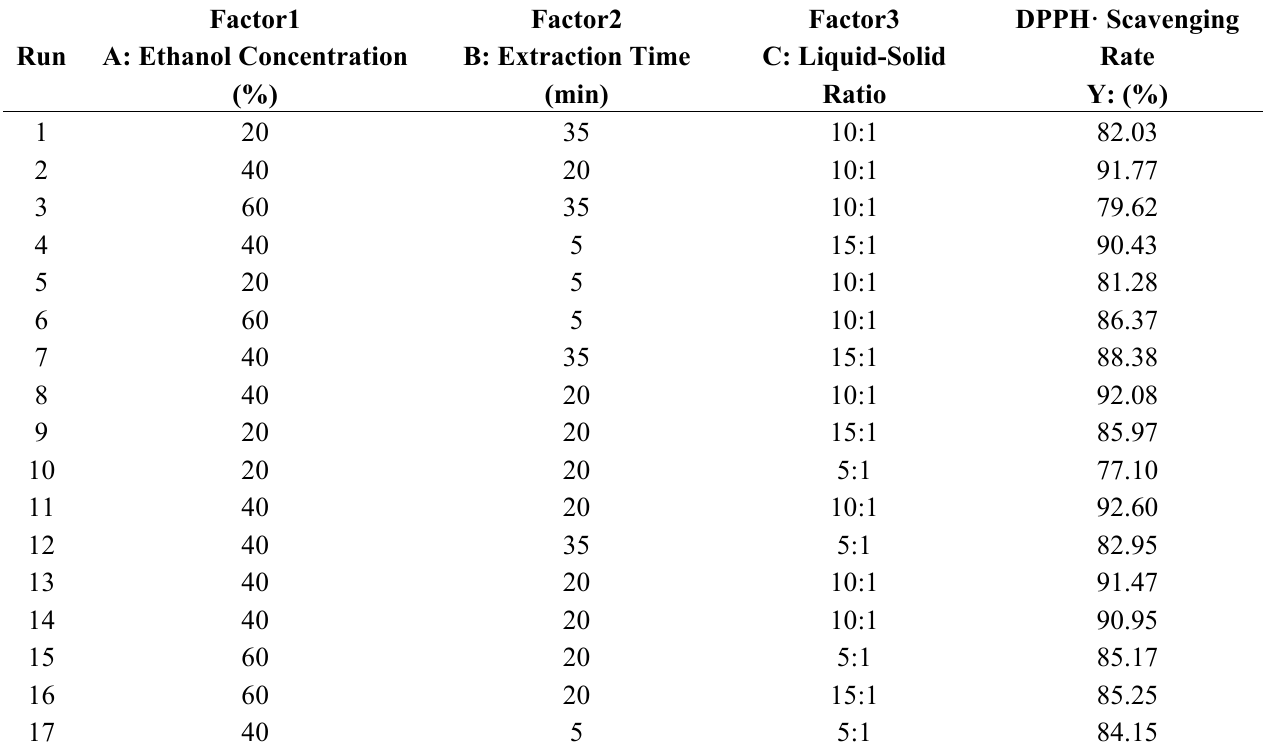
Table 1. Response surface analysis program and results for sumac extract.